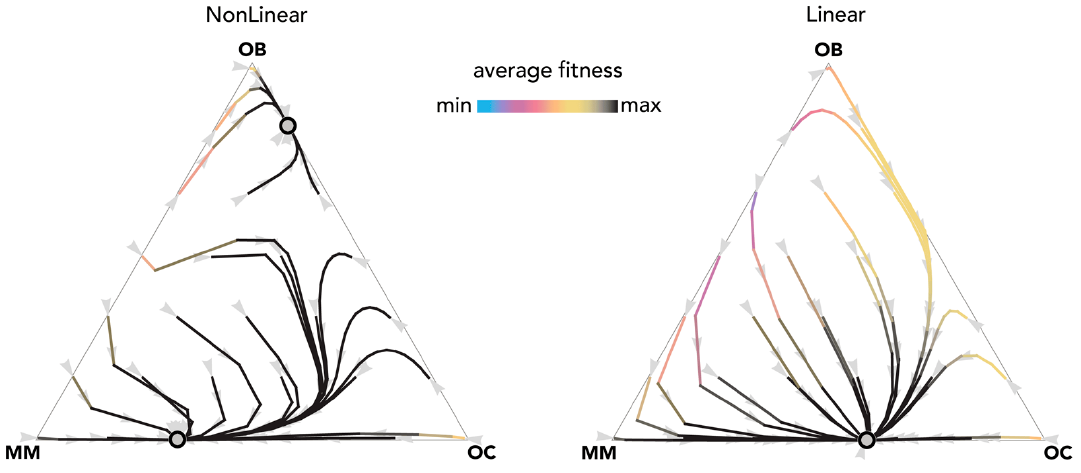
Figure 3. Nonlinear benefits can lead to an additional mixed equilibrium on the OB–OC edge. The distance from each vertex is inversely proportional to the frequency of each type. Arrows show the direction of the dynamics; colors show the average fitness of the population. N = 25; c i = 0.1; B OC,OC = 0.6; B OC,OB = 1.1; B OC,MM = 2; B OB,OC = 1; B OB,OB = 0.6; B OB,MM = 0; B MM,OC = 3; B MM,OB = − 0.5; B MM,MM = 1; h OC,OC = 0; h OC,OB = 0.01; h OC,MM = 0.2; h OB,OC = 0.05; h OB,OB = 0.05; h OC,MM = 0.2; h MM,OC = 0.5, h MM,OB = 0.5; h MM,MM = 0.5. Nonlinear: s OC,OC = 50; s OC,OB = 30; s OC,MM = 50; s OB,OC = 30; s OB,OB = 30; s OB,MM = 30; s MM,OC = 5; s MM,OB = 20; s MM,MM = 50; Linear: s i,j → 0.